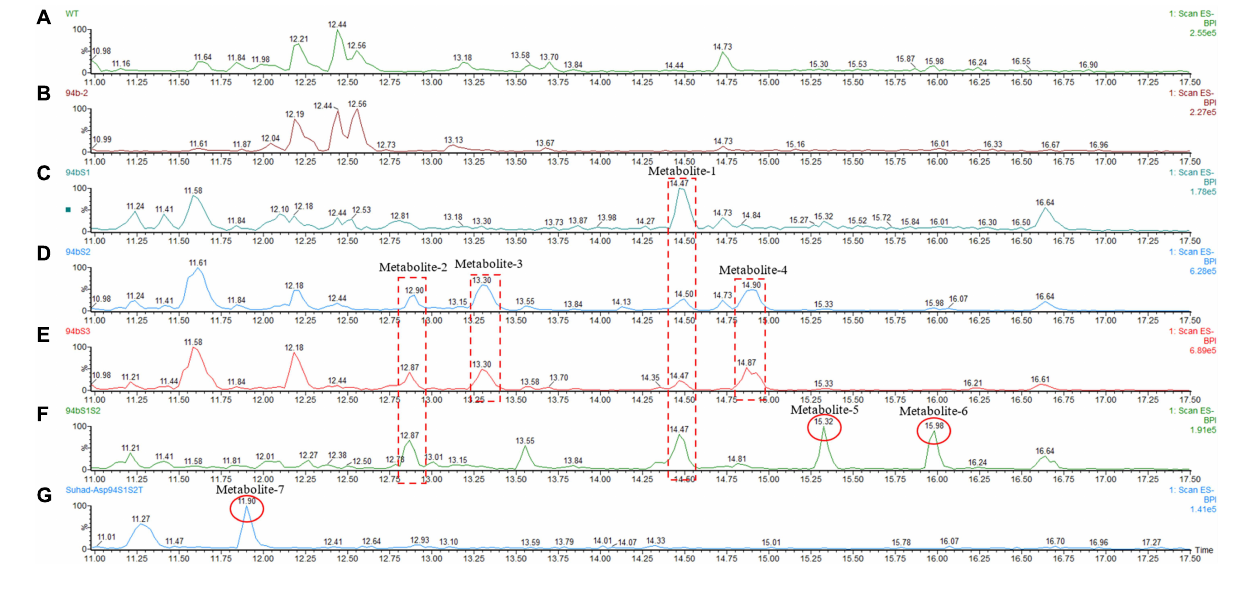
FIGURE 9 | Negative ion LC-MS spectrum (-ESI) comparison of NSAR1-WT with transgenics of single, double, and triple biosynthetic genes of the humulene biosynthetic gene cluster. The genes investigated in this experiment were: one terpene cyclase (humulene synthase), three genes of short-chain dehydrogenase reductase (SDR), and one tyrosinase, all selected from the terpene synthase biosynthetic gene cluster located in contig 94 of the Hypholoma fasciculare genome. (A) NSAR1-WT. (B) NSAR1-humulene synthase. (C) NSAR1-humulene synthase-SDR1. (D) NSAR1-humulene synthase-SDR2. (E) NSAR1-humulene synthase-SDR3. (F) NSAR1-humulene synthase-SDR1-SDR2. (G) NSAR1-humulene synthase-SDR1-SDR2-Tyrosinase. The mass spectrum was selected from min 11 to min 17.50 to avoid peaks overlapping. In total, seven new peaks were detected at retention times (RTs) of 12.87, 13.30, 14.47, 14.90, 15.32, 15.98, and 11.90 within this comparison. The transgenic NSAR1-humulene synthase-SDR1 showed the lowest number of new peaks compared to the other transgenics: NSAR1-humulene synthase-SDR2, NSAR1-humulene synthase-SDR3, and NSAR1-humulene